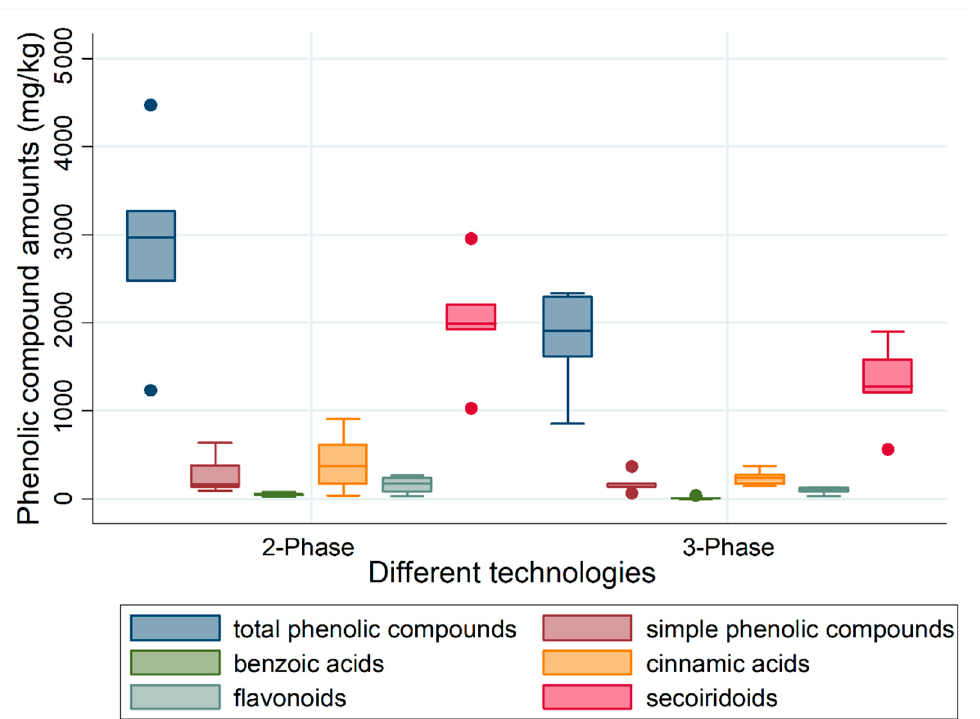
Figure 3. Total phenolic compound and phenolic compound composition according to technology used (two-phase separating decanter and three-phase separating decanter).